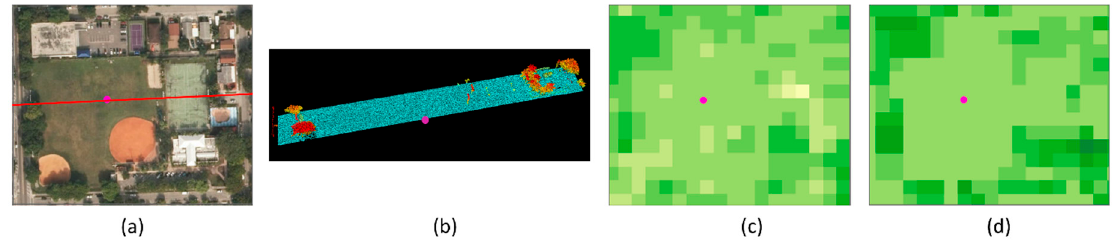
Figure 3. (a) Aerial photograph, (b) LiDAR points, (c) TDX DEM, and (d) LiDAR DSM for an open ground sample site. Both TDX DEM and LiDAR DSM have a horizontal resolution of 12 m.